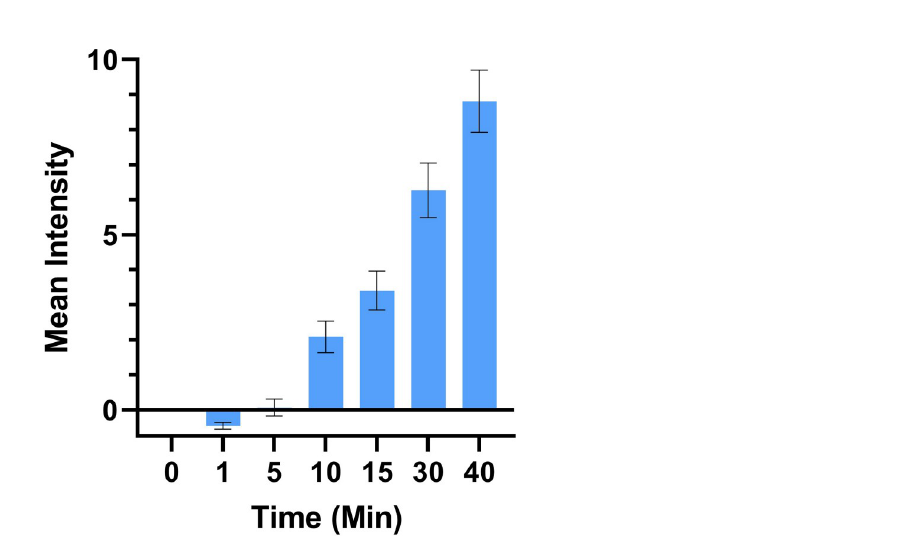
Fig 5. Quantitation of internal cellular fluorescence as a function of time. Background-subtracted fluorescence as a function of time. Intensities are the average of three separate experiments. Error bars represent S.E.M.